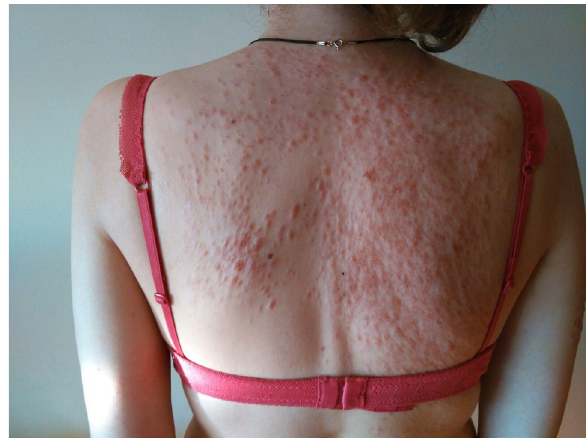
Figure 1: Cutaneous leiomyomas on patient’s back, leading to suspicion of hereditary leiomyomatosis and renal cell cancer (HLRCC).